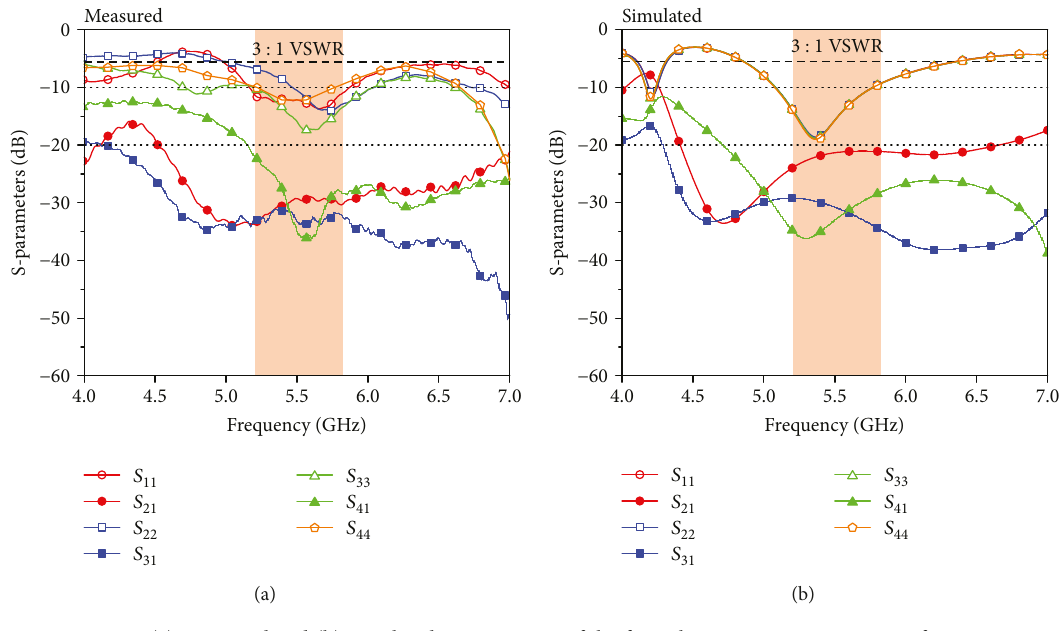
Figure 7: (a) Measured and (b) simulated S-parameters of the four-element MIMO antenna in free space.